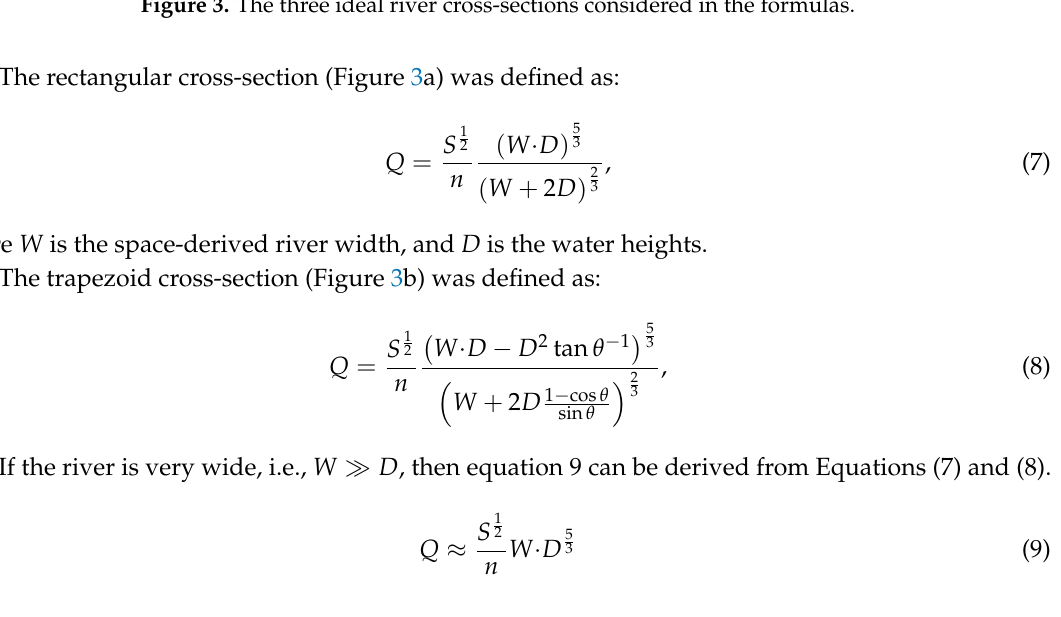
Figure 3. The three ideal river cross-sections considered in the formulas.